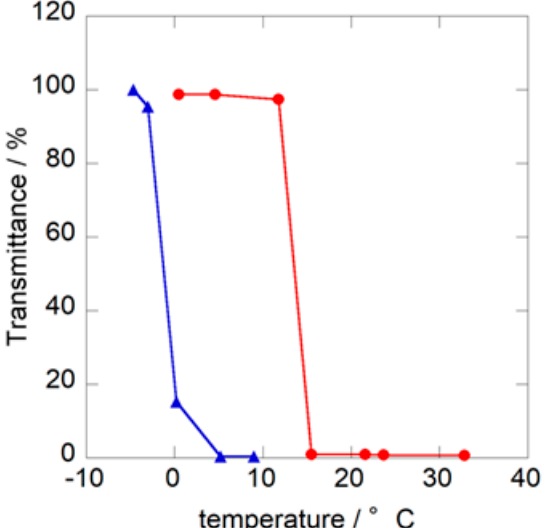
Figure 1. Temperature dependence of transmittance for the PNIPAM solution; ( ● ) X M = 0.2; ( ▲ ) X M = 0.3.